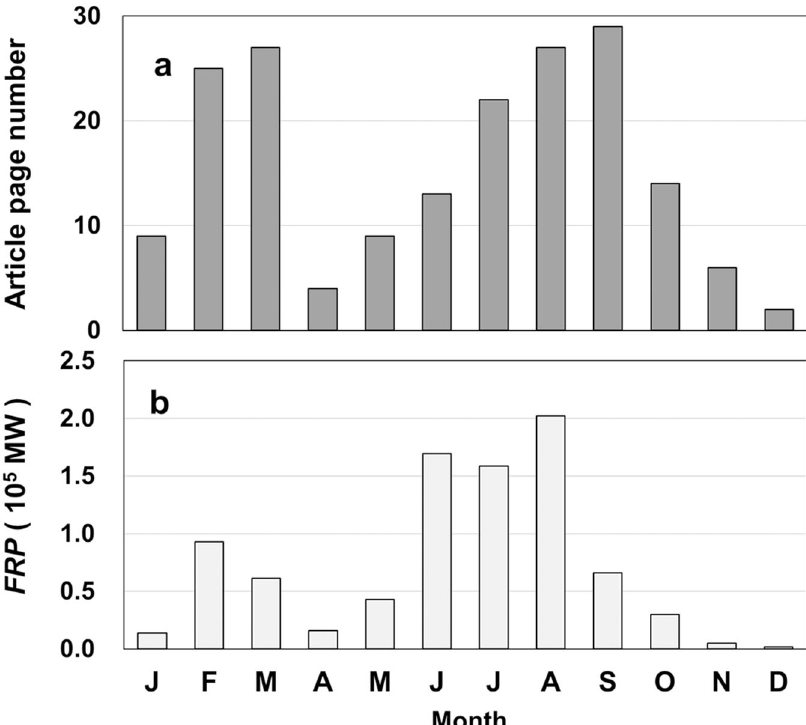
Fig. 5 Monthly data accumulated during 2009 – 2018. a Article page number of “ acute respiratory illness ” , b FRP . R = 0.62, 0.74, and 0.28 with time-lag zero, one, and 2 months in the distribution of page number, respectively.